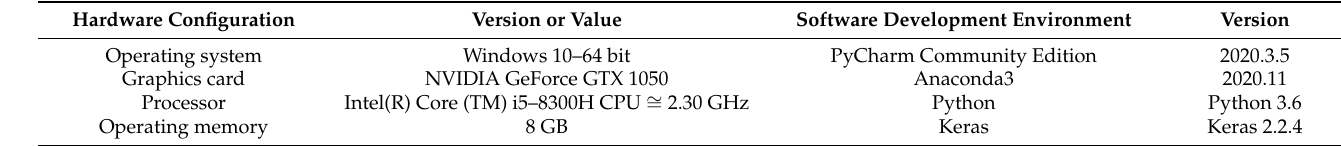
Table 1. The hardware configuration and software development environment.